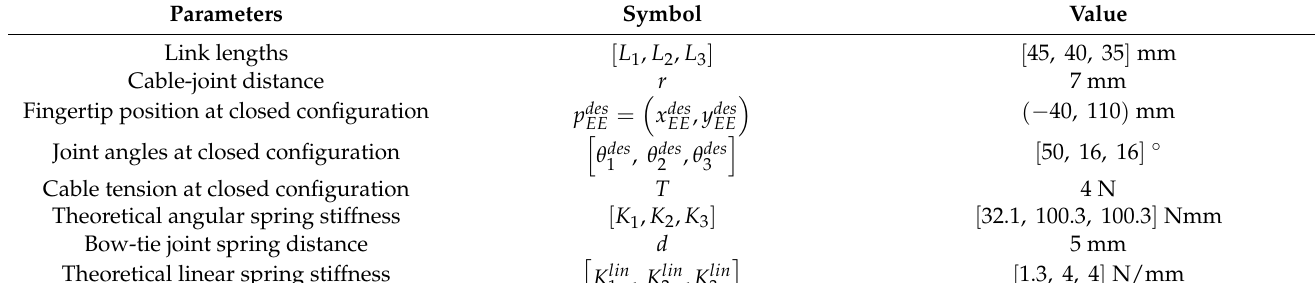
Table 4. Parameters used in the modelling of the finger.